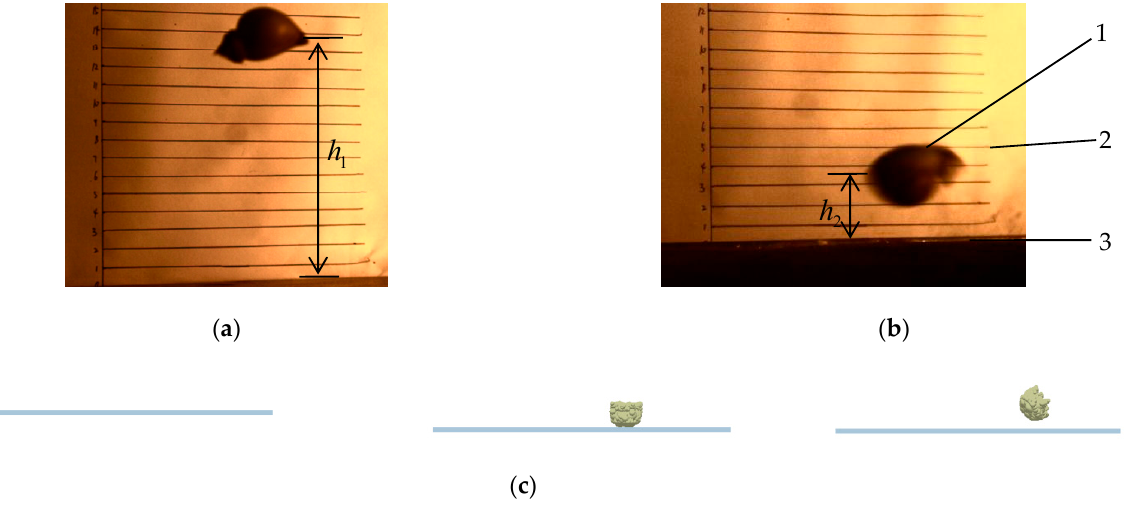
Figure 3. Calibration experiment of restitution coefficient. ( a ) Freely dropped height; ( b ) Highest bounce height; ( c ) Simulation test. 1. Lily bulb; 2. Graph paper; 3. Q235 steel.